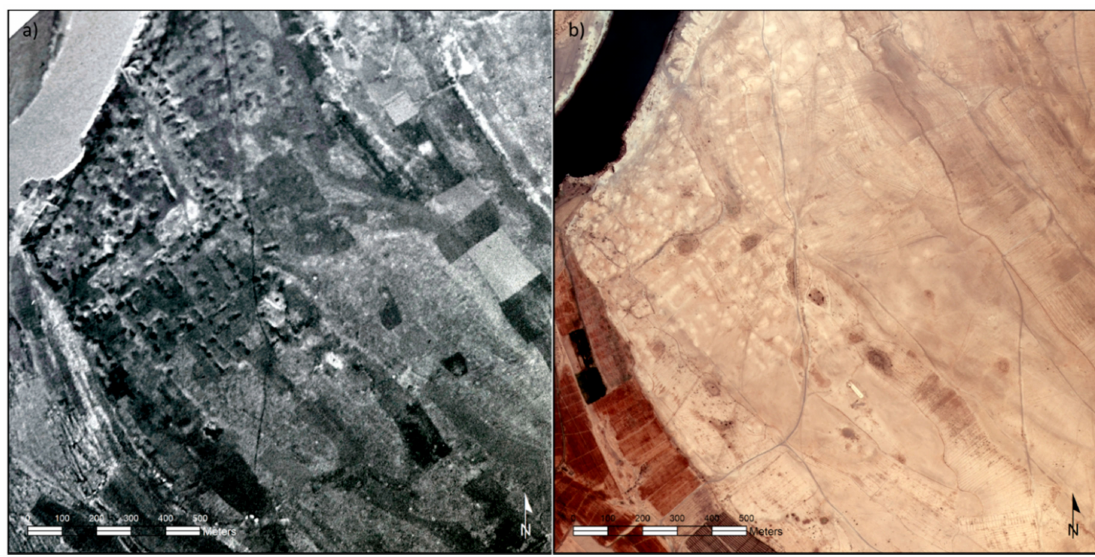
Figure 1. The importance of using historical aerial images: ( a ) Aerial image of a deserted medieval city located on the Tigris river, taken by the RAF in 1944; ( b ) the current state of the site—totally deserted (author: Lenka Starkov á